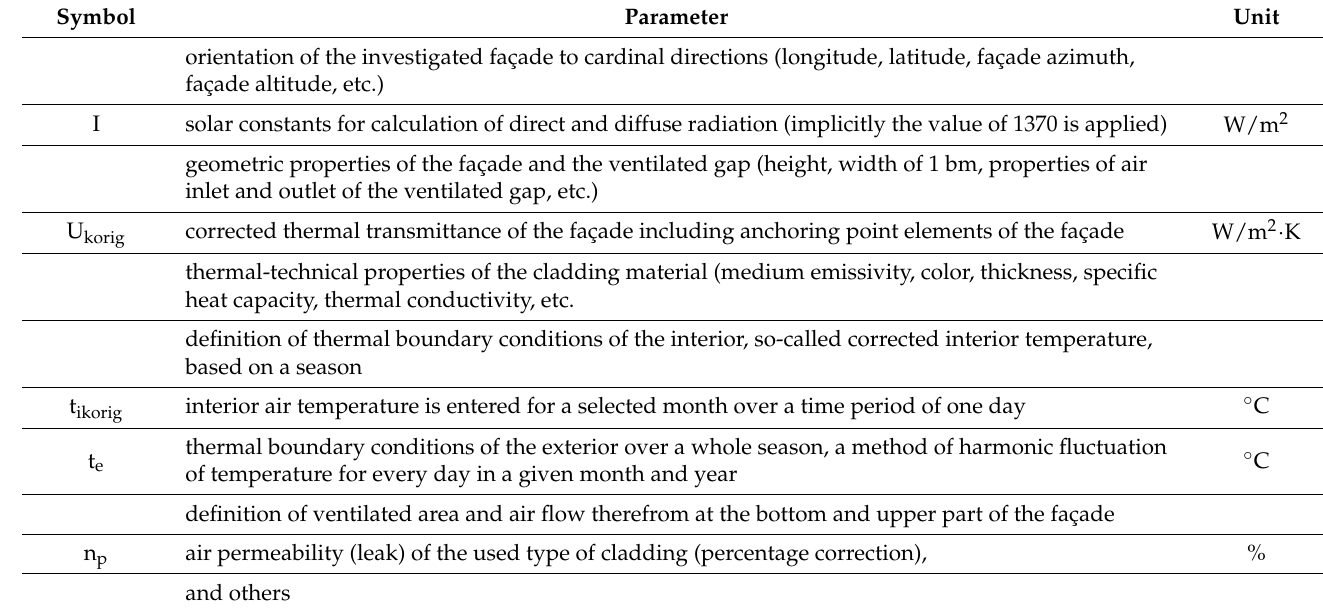
Table 3. Main boundary conditions are defined as follows.